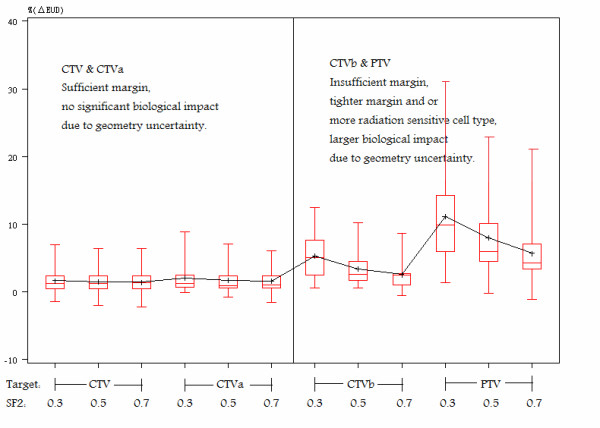
Box plot of %(ΔEUD) vs. different CTVs with different radiation sensitivity. The range indicated by the error bars, the 1st and median and the third quartiles, shown as a line, and upper and lower limits of the box, respectively and the average indicated by the points for different margins as indicated by CTV, CTVa and CTVb.for a) SF2 = 0.3, b) SF2 = 0.5, and c) SF2 = 0.7 on the x-axis.